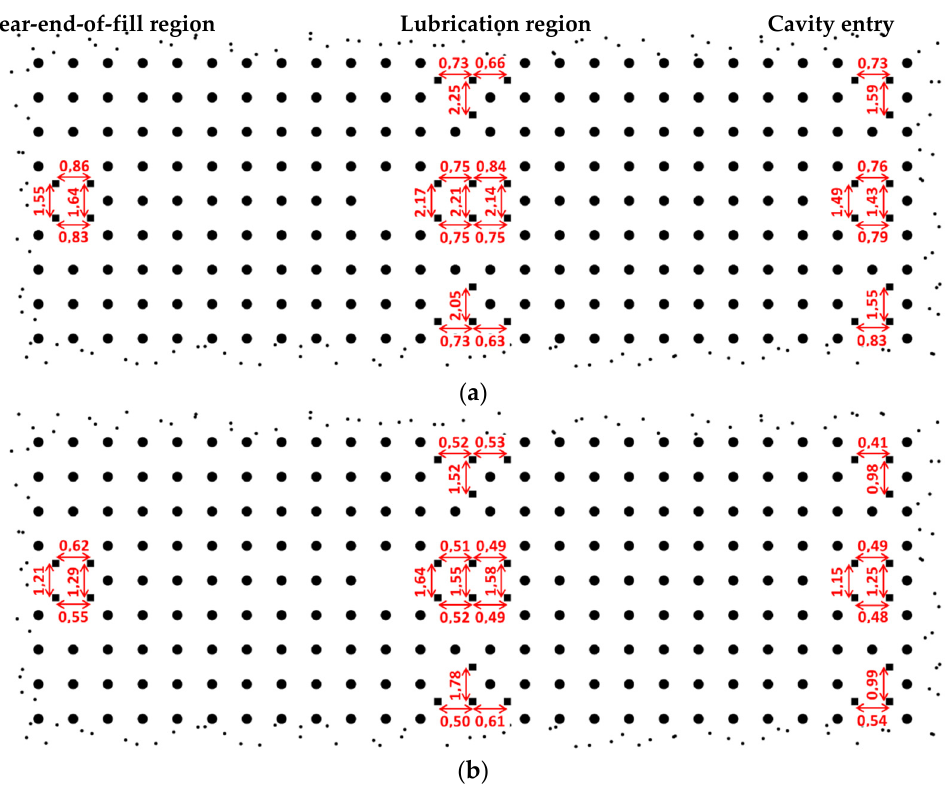
Figure 16. Longitudinal and transverse shrinkage measurements (in %) on biocomposite parts injected at 30 mm/s ( a ) without and ( b ) with packing pressure.